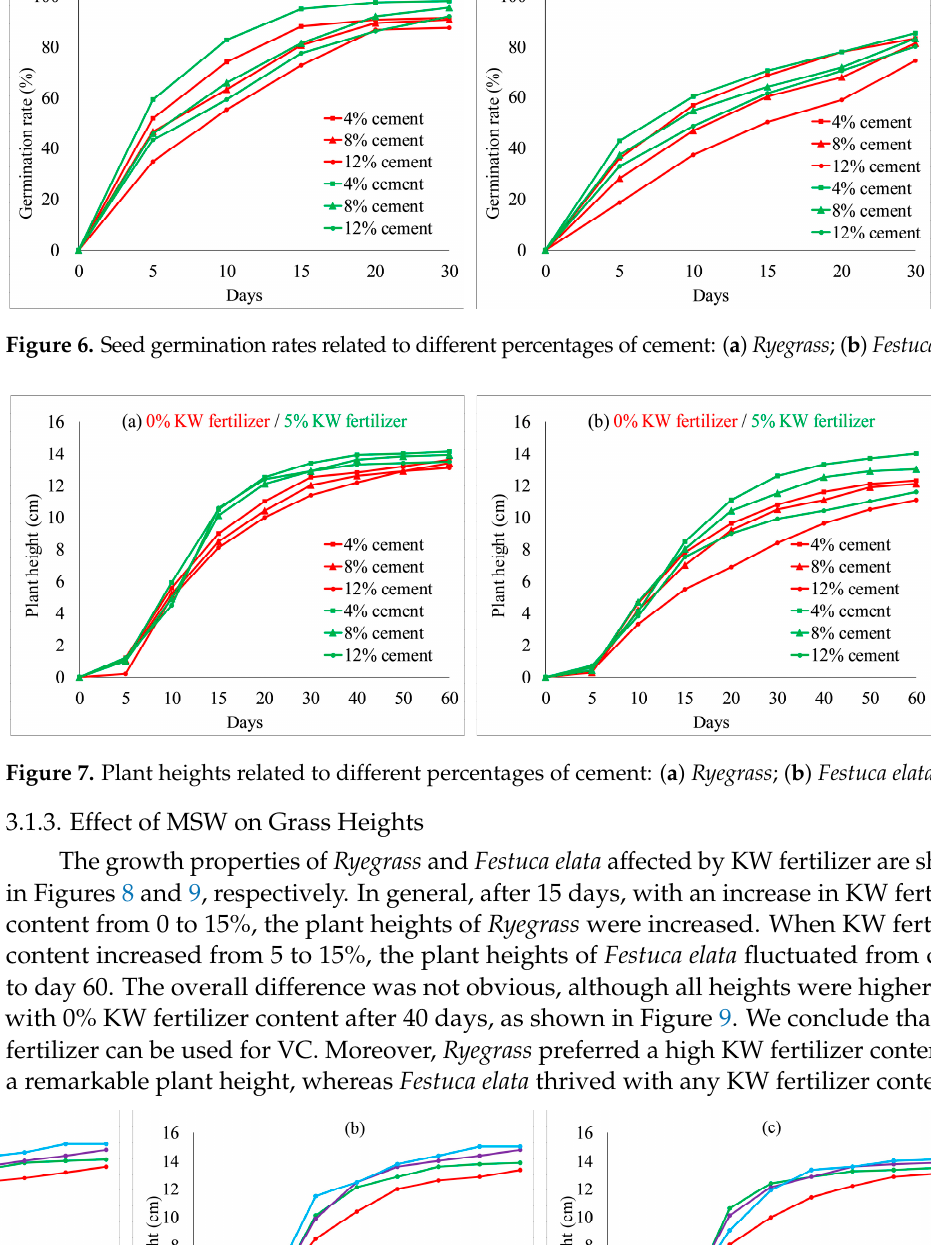
Figure 9. Festuca elata height relative to KW fertilizer content with different percentages of cement: ( a ) 4% cement; ( b ) 8% cement; ( c ) 12% cement. Considering the trade-off between mechanical property and vegetation characteris- tics of VC, the percentage of the cement content in the following VC samples was con- trolled as 8%. Figures 10 and 11 show the effect of silica fume content on the plant height. With the increase in silica fume content from 0 to 8%, the plant heights of each group fluctuated from day 0 to day 25. The plant heights were the lowest when the silica fume content reached the highest concentration (8%) in each group at 60 days. However, when the ratio of KW fertilizer content was 5%, with an increase in silica fume content from 0 to 6%, the plant heights of both species were increased from day 30 to day 60, as presented in Figures 10a and 11a. When the ratio of KW fertilizer content increased to 10%, with an increase in silica fume content from 4% to 8%, the plant heights of Festuca elata were de- creased obviously after 20 days, as shown in Figure 11b. This may indicate a combined action of KW fertilizer and silica fume content on plant height, so the addition of silica fume content should be considered together with the KW fertilizer content.